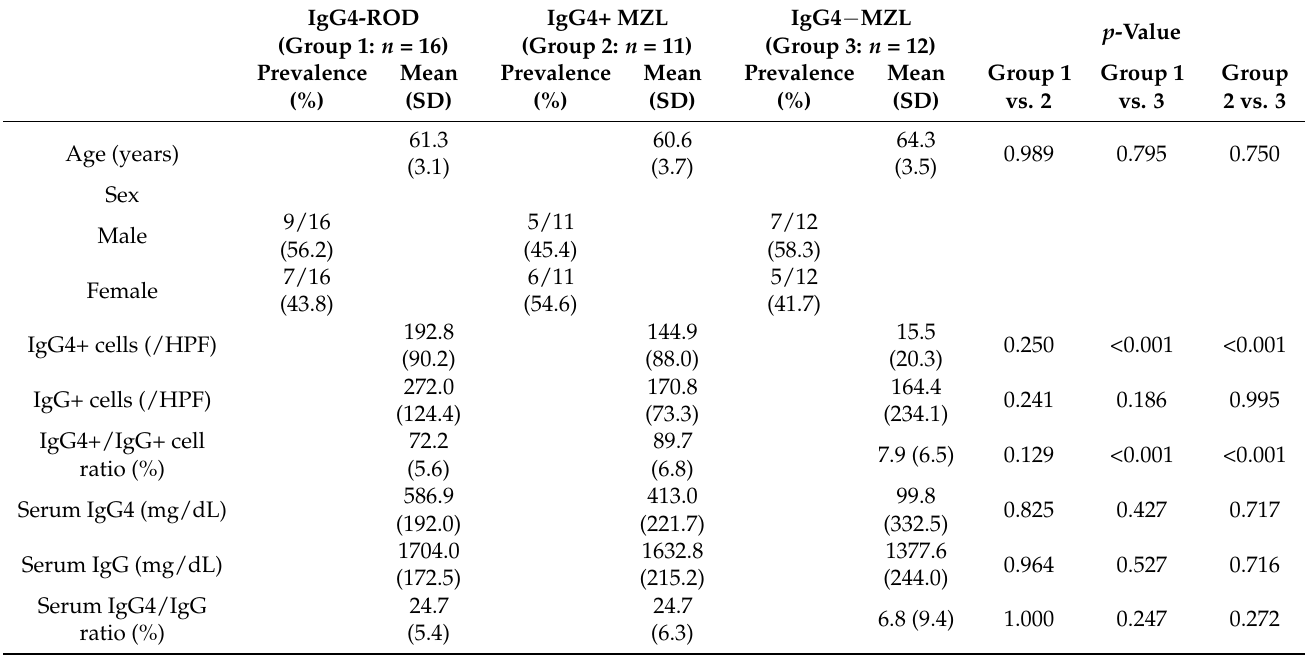
Table 1. Basic demographics and clinicohistological